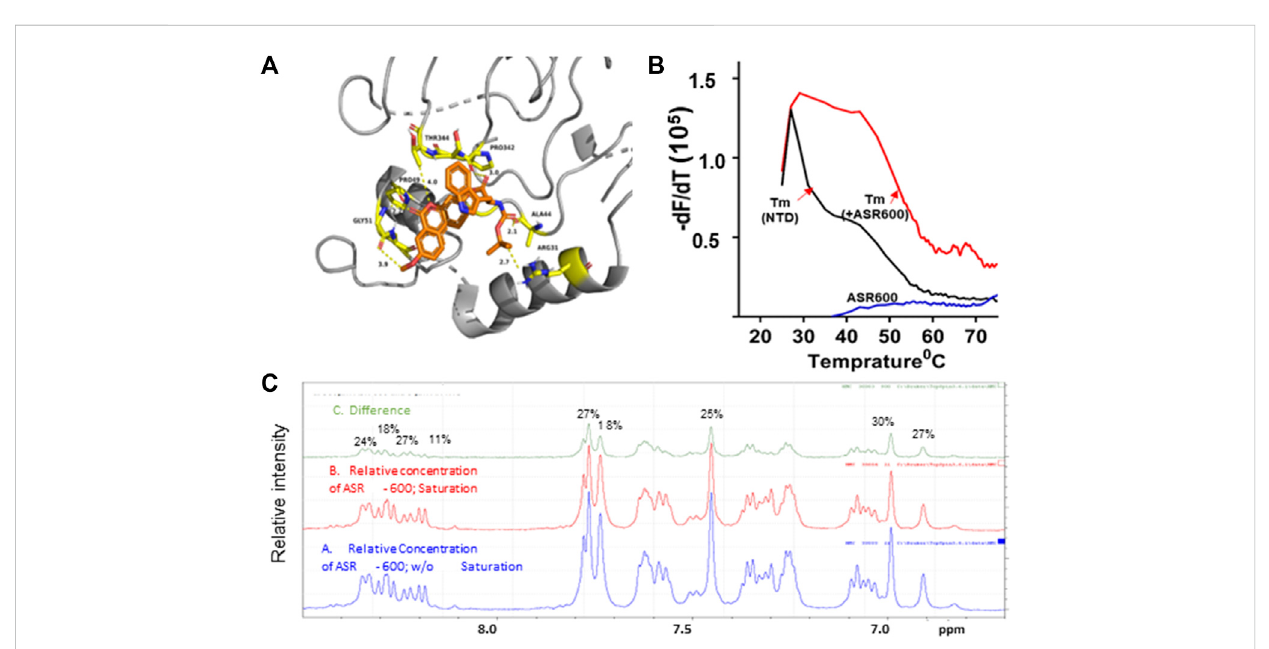
FIGURE 7 Physical interaction between ASR 600 and AR- NTD: (A) . AR-NTD residues participating in potential electrostatic and steric interactions with ASR- 600 are depicted in yellow stick representation. The AR-NTD backbone is shown as a cartoon in gray, and ASR-600 is represented as an orange stick representation. (B) . GloMelt ™ thermal shift assay was performed on NTD (5 µg) in the presence of ASR-600. The binding stabilized the protein, as indicated by the shift in the melting curves. (C) . NMR STD experiment results of ASR-600 with AR-NTD; the STD effect varied from 18 to 30%.